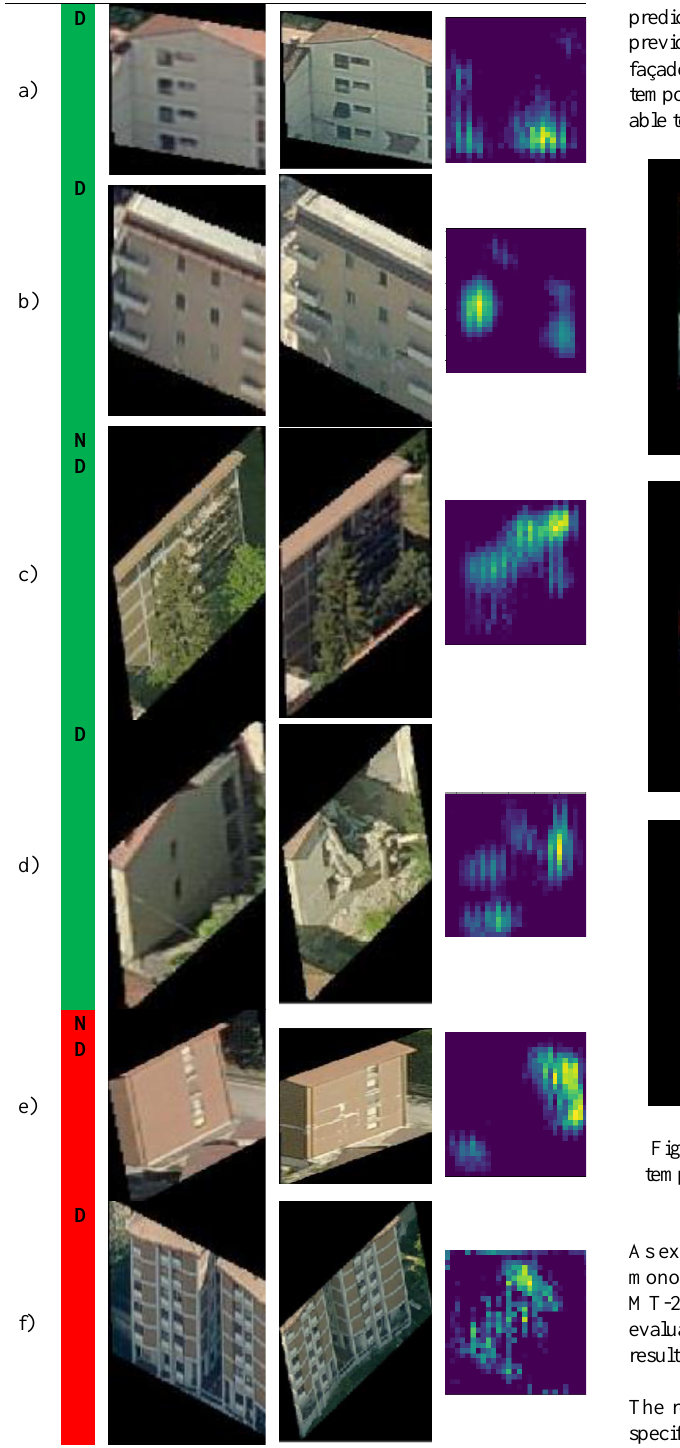
Figure 8. Pre- and post-event façade image patch and one of the activations coming from the activation layer of the last convolutional set of the MT-2str-c. On the left column, red means the prediction was correct and green means the prediction was incorrect. D stands for damaged and ND for not- damaged